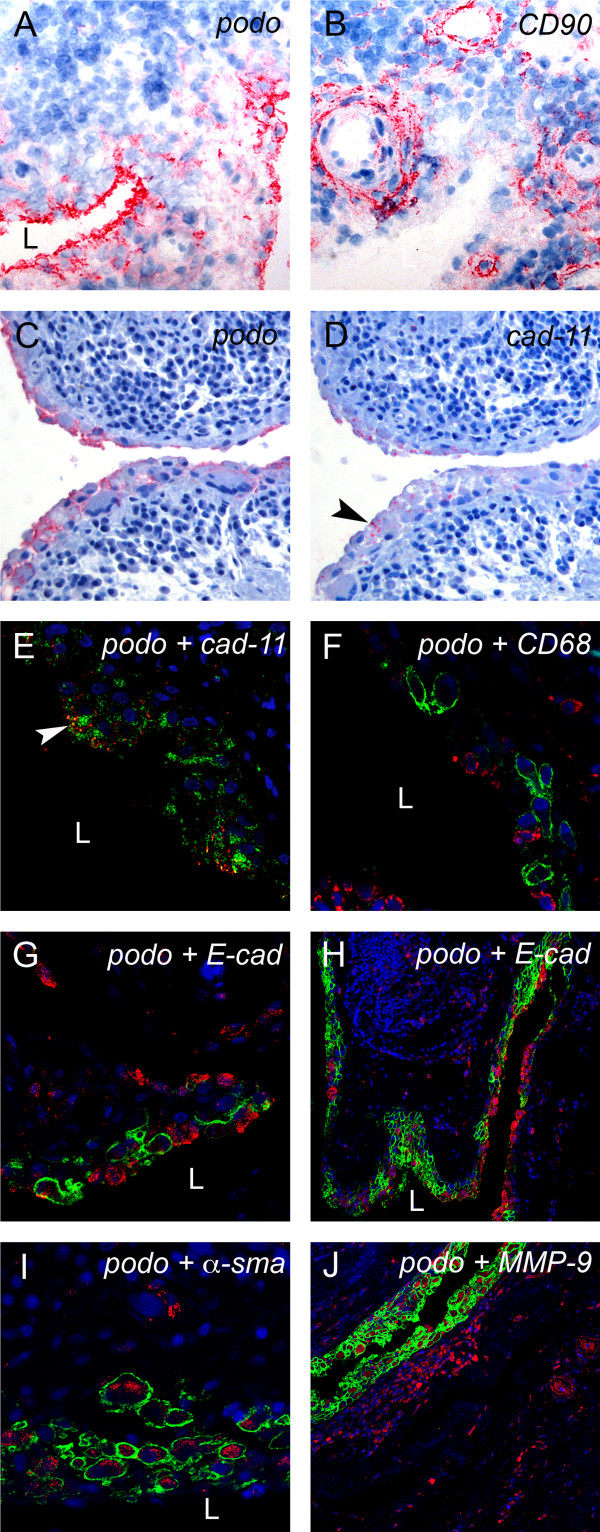
Podoplanin is expressed in FLS in areas of synovial transformation. Immunohistochemistry of (A and B) frozen and (C-J) paraffin-embedded human synovial tissue from patients with rheumatoid arthritis (RA) using antibodies against (A and C) podoplanin (D2-40), (B) CD90 (AS02) and (D) cadherin-11 (3B2H5) (arrowhead). Double immunofluorescence staining analysed by confocal microscopy showing, in green, (E) podoplanin 18H5 and (F-J) podoplanin D2-40, and in red, (E) cadherin-11 (3B2H5), (F) CD68 (KP1), (G and overview in H) E-cadherin (H-108), (I) α-smooth muscle actin (α-sma) (PA1-37024) and (J) matrix metalloproteinase 9 (MMP-9). (E) Note colocalization of podoplanin and cadherin-11 (arrowhead). L, lumen.